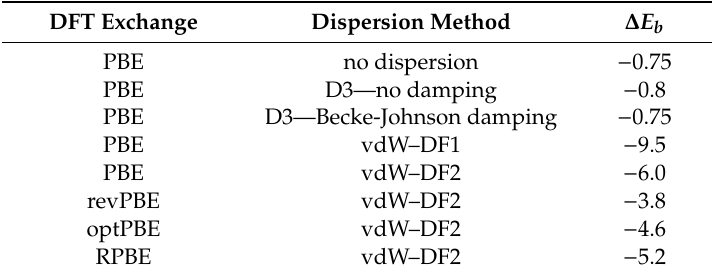
Table 6. Comparison of H 2 binding energy ( ∆ E b in kJ / mol H 2 ) for di ff erent dispersion correction and